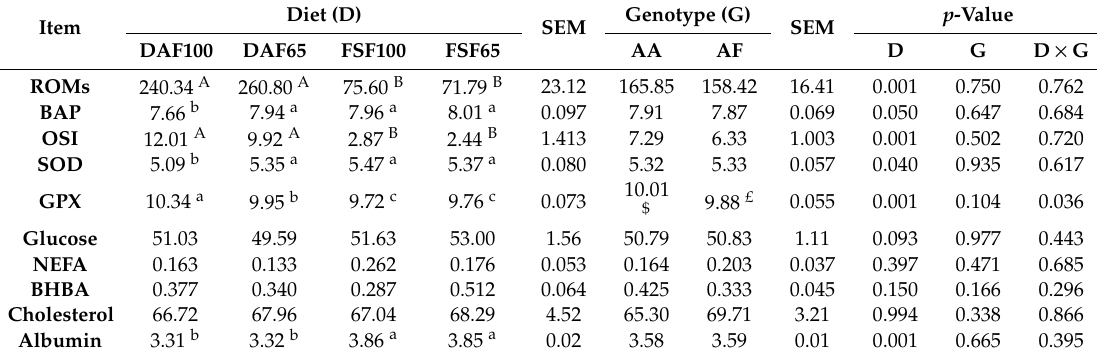
Table 2. Least squares means of ROMs (U.Carr), BAP ( Ln μmol/L) , SOD (Ln U/mL whole blood), GPX (Ln U/L whole blood), Glucose (mg/100 mL), NEFA (mmol/L), BHBA (mmol/L), Cholesterol (mg/100 mL) and Albumin (Ln g/L) in dairy goats with different genotype fed dry and fresh diets ad libitum.